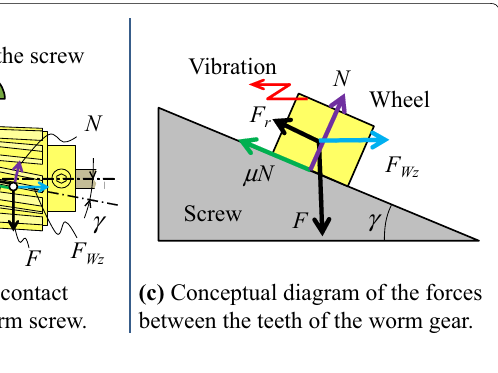
(b) Details of the forces acting at the contact point of the worm wheel and the worm screw. Fig. 4 Vibration to the wheel-axis